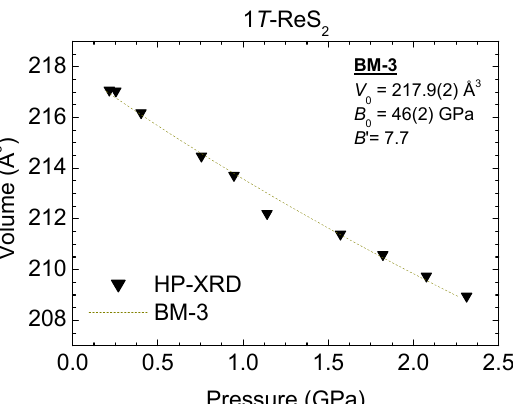
Figure 5. Experimental pressure dependence of the unit-cell volume of 1T-ReS 2 as obtained with powder XRD measurements (solid triangles). The dashed curve corresponds to the result of a fit using a 3rd-order Birch–Murnaghan (BM) equation of state.